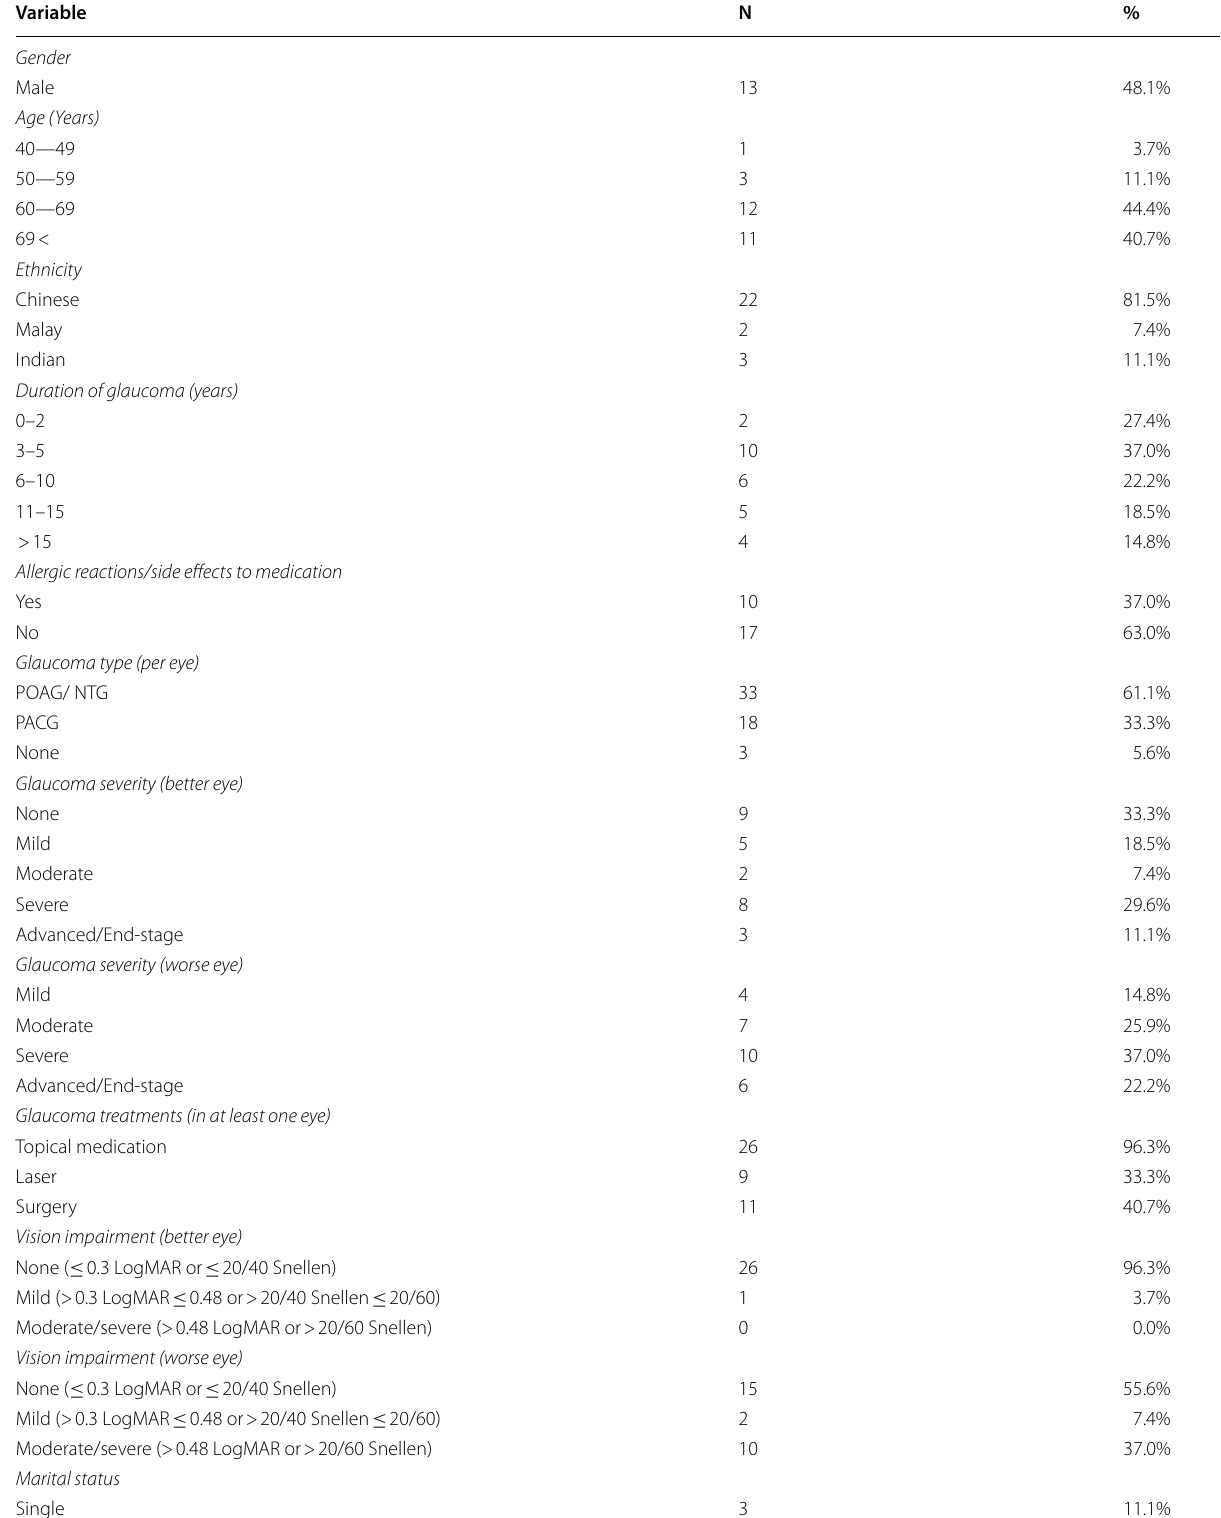
Table 3 Sociodemographic and clinical characteristics of the 27 participants in Phase 1 Variable